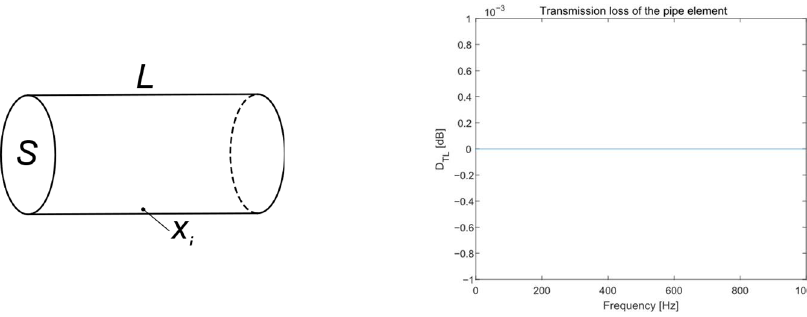
Figure 3. Straight pipe sketch ( left ) and example of TL obtained with TMM ( right ).